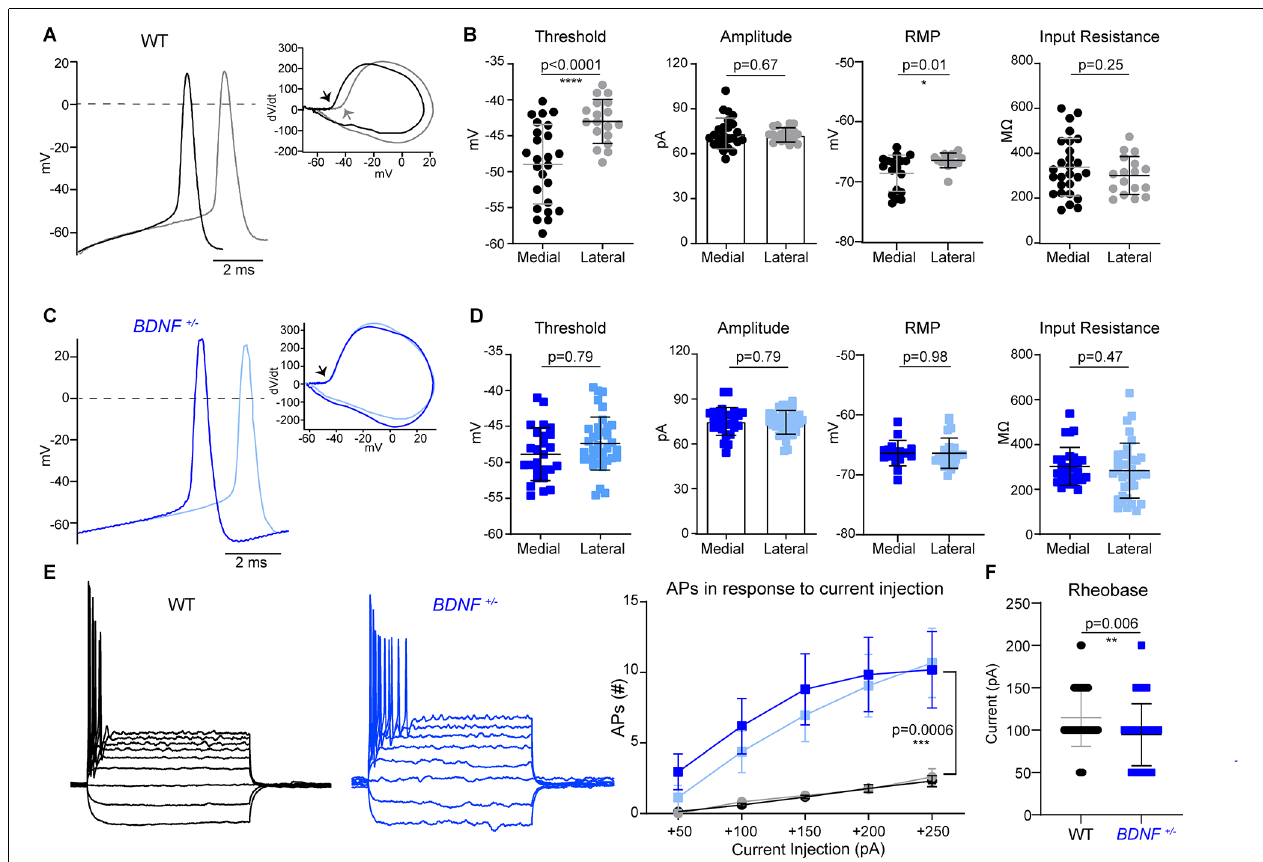
FIGURE 2 | The difference in MNTB neuron intrinsic properties along the tonotopic axis is abolished in BDNF + / − mice. (A) Representative traces of APs evoked by current injection from medial (black) and lateral (gray) MNTB neurons in WT. Inset, dV/dt phase plot against membrane potential. The arrow points to the AP threshold, which differs between medial and lateral WT neurons. (B) Summary of AP threshold; determined as the membrane potential at dV/dt = 10, AP amplitude; determined as the difference between threshold and peak potential of AP, resting membrane potential, and input resistance of WT neurons. Each point represents an individual cell from 13 mice (medial) and seven mice (lateral). * indicates p < 0.05 and **** indicates p < 0.0001. (C) Representative traces of APs from BDNF + / − medial (dark blue) and lateral (light blue) neurons. dV/dt phase plot shows no difference in AP threshold between medial and lateral. (D) Summary of AP threshold, amplitude, resting membrane potential, and input resistance from BDNF + / − MNTB neurons. n = 10 mice (medial) and nine mice (lateral). (E) Membrane potential changes in WT and BDNF + / − neurons in response to step-like current injections from − 100 pA to +250 pA in increments of 50 pA (left). The number of spikes in response to depolarizing current injection (right). Repeated measures ANOVA displayed significant difference based on genotype ( F (1,99) = 12.55; p = 0.0006). *** indicates p < 0.001. (F) Rheobase current was quantified by genotype in WT and BDNF + / − neurons. ** indicates p <